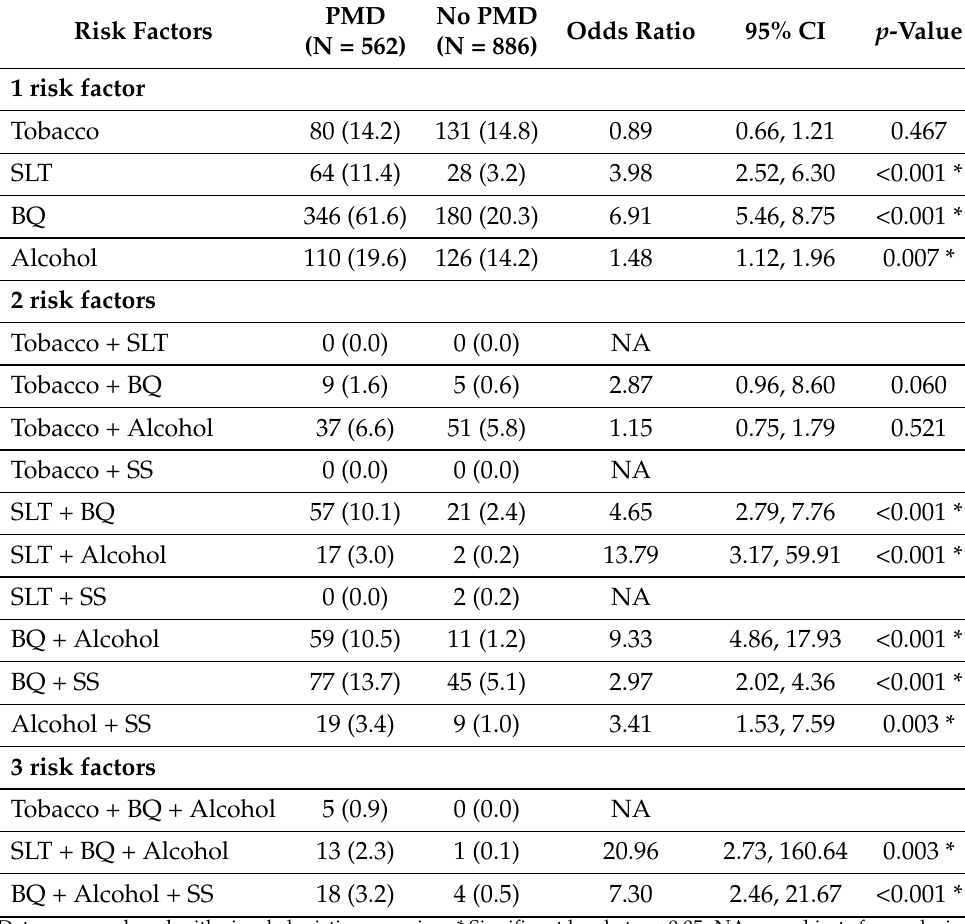
Table 5. Odds ratio of combined risk factor exposure characteristics with OPMDs occurrence.